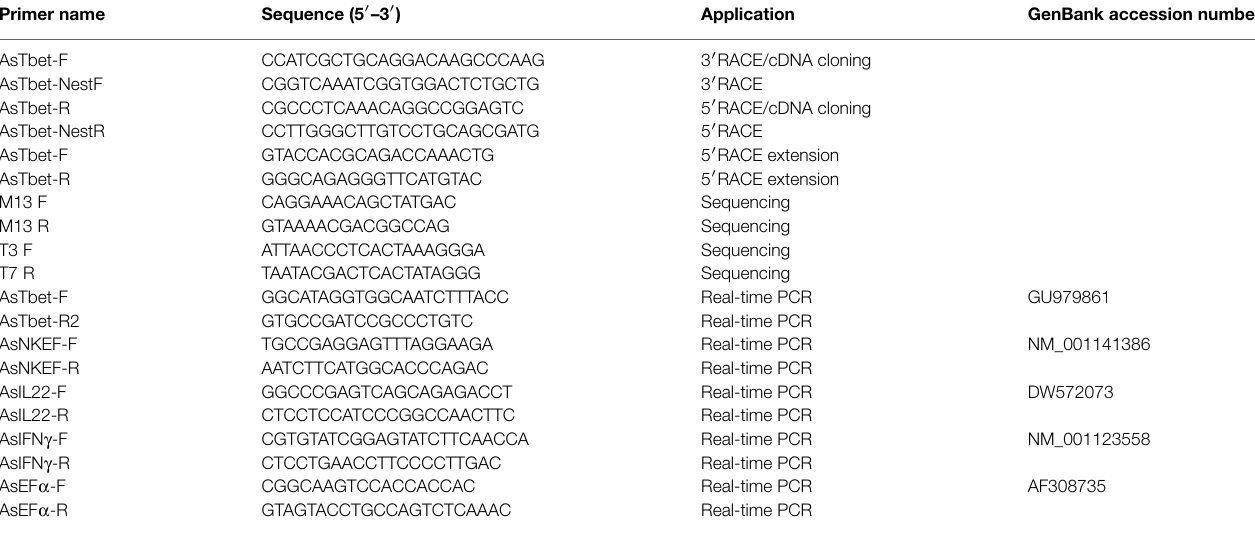
TABLE 1 | List of primers and their designated applications